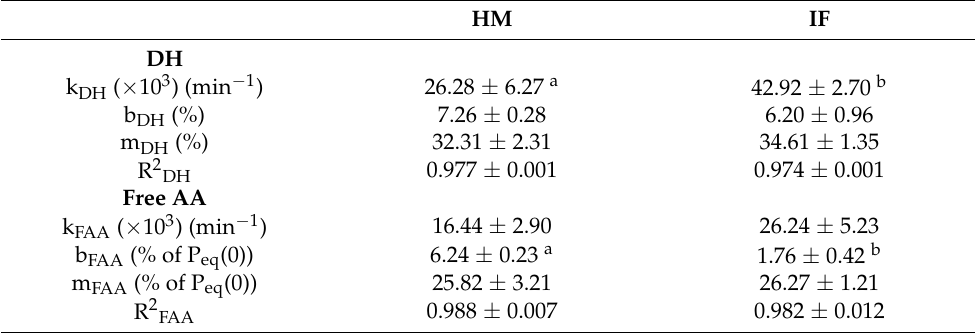
Table 3. Curve fitting values of infant milk protein hydrolysis in SIM intestinal phase 1